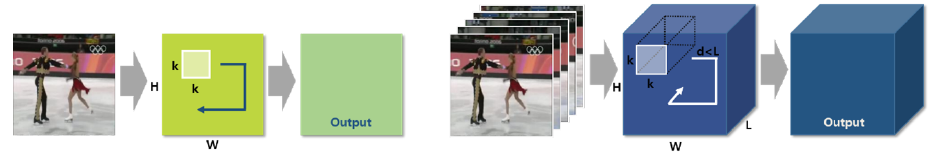
Figure 2. Structure of 2D and 3D convolution